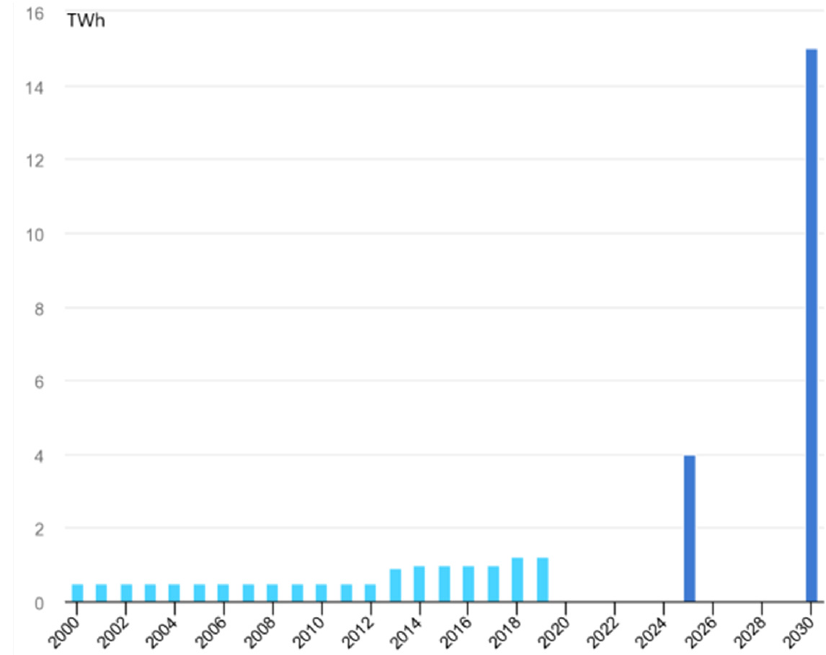
Figure 19. Ocean power generation scenarios from 2000 to 2030.